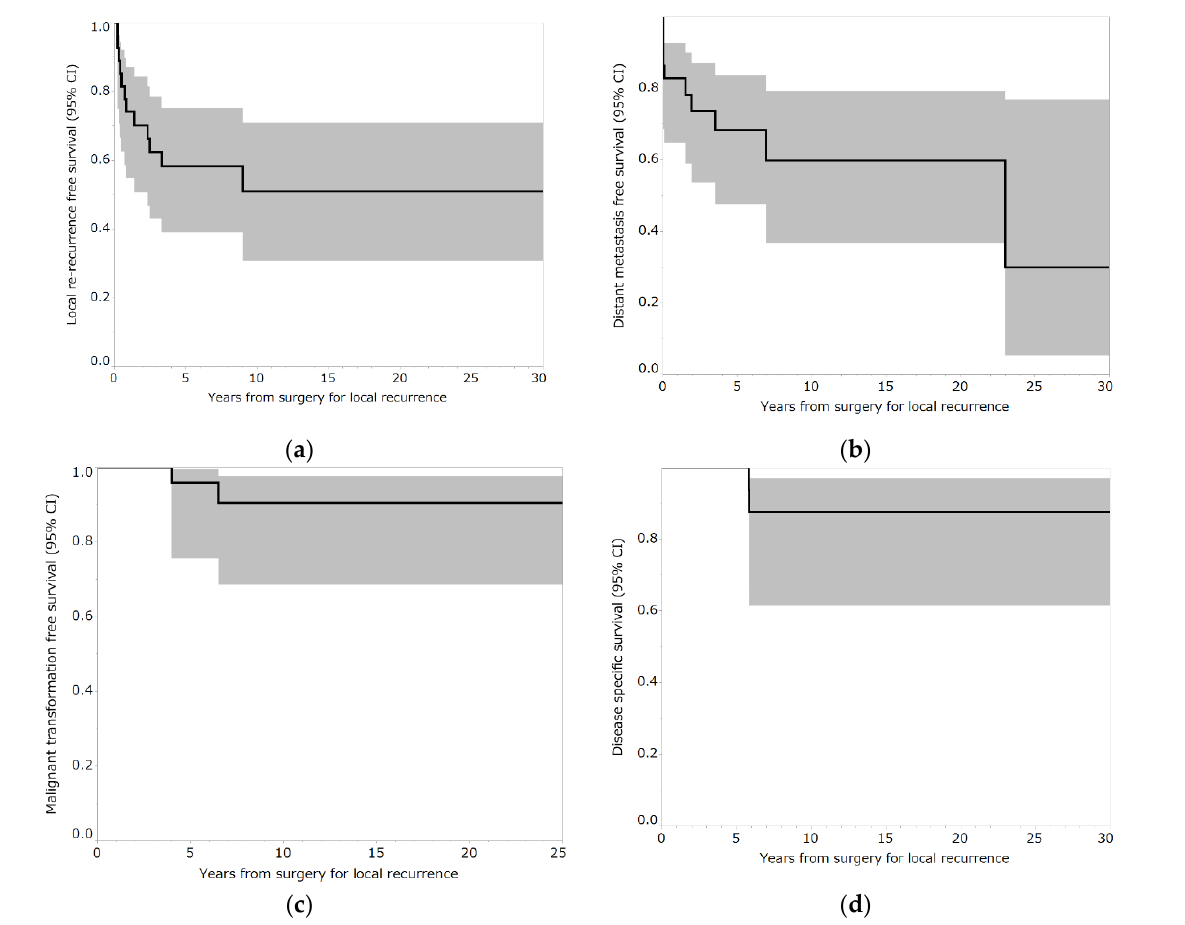
Figure 2. ( a ) Local re-recurrence-free survival rates of patients who underwent reoperation for local recurrence following en bloc resection for bone giant cell tumor of the extremities. Shading around the curves represents 95% confidence intervals (CI). ( b ) Distant metastasis-free survival rates of patients who underwent reoperation for local recurrence following en bloc resection for bone giant cell tumor of the extremities. Shading around the curves represents 95% CI. ( c ) Malignant transformation-free survival rates of patients who underwent reoperation for local recurrence following en bloc resection for bone giant cell tumor of the extremities. Shading around the curves represents 95% CI. ( d ) Disease-specific survival rates of patients who underwent reoperation for local recurrence following en bloc resection for bone giant cell tumor of the extremities. Shading around the curves represents 95% CI. Table 3. Details of 29 patients with GCTB of the extremities who experienced local recurrence after en bloc resection.